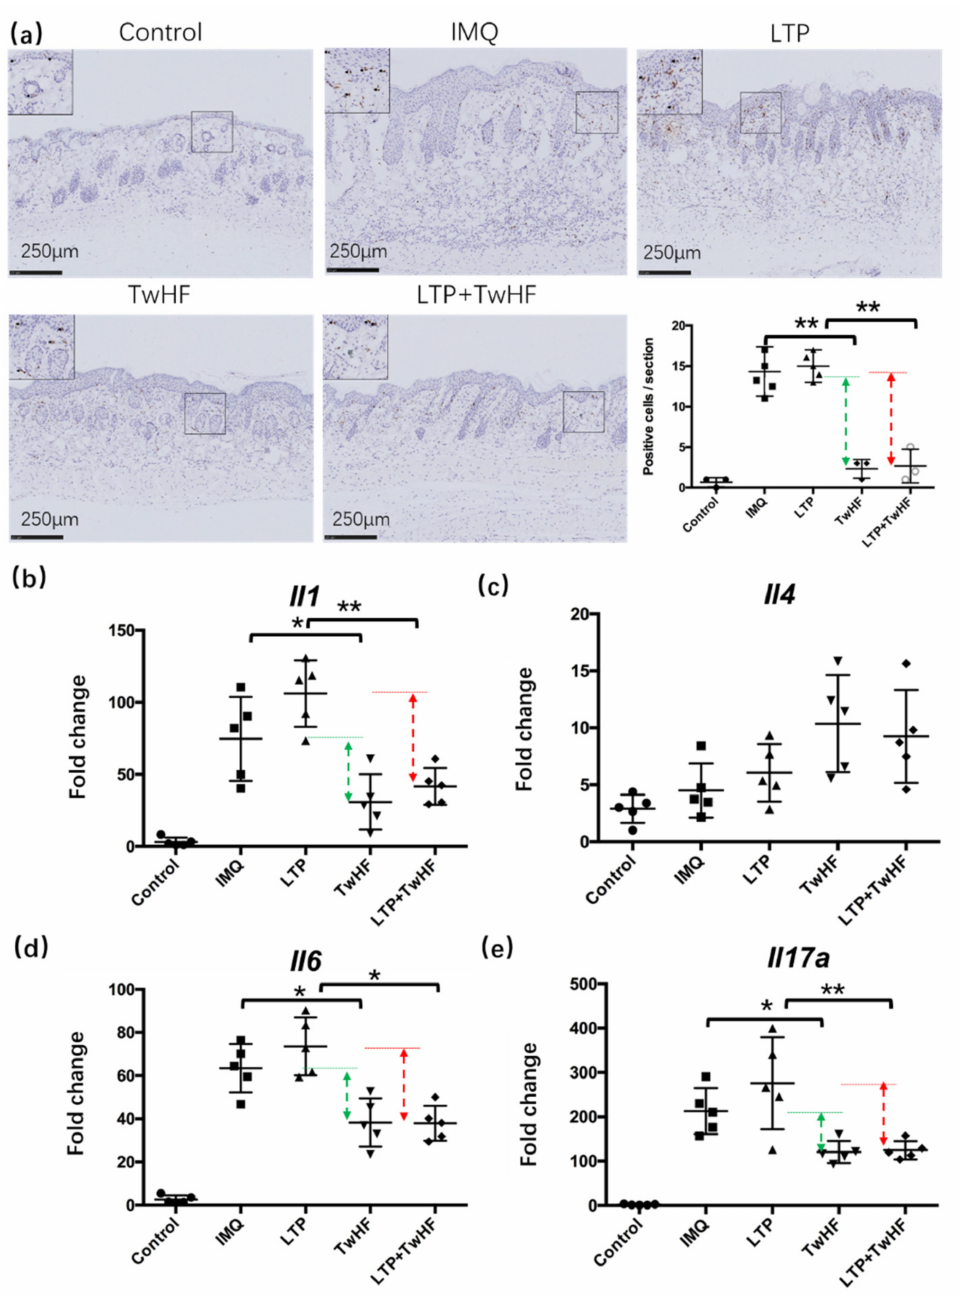
Figure 9. LTP + TwHF treatment inhibited inflammatory cell infiltration and the release of inflam- matory cytokines in the skin in the IMQ-induced mice model. ( a ) Immunohistochemical staining of CD3+ cells in skin lesion. ( b – e ) The mRNA expression of psoriasis associated with inflammatory cytokines in the skin lesion in the mice model. Data are shown as mean ± SD ( a – e ). n = 5 mice. * p < 0.05 and ** p <